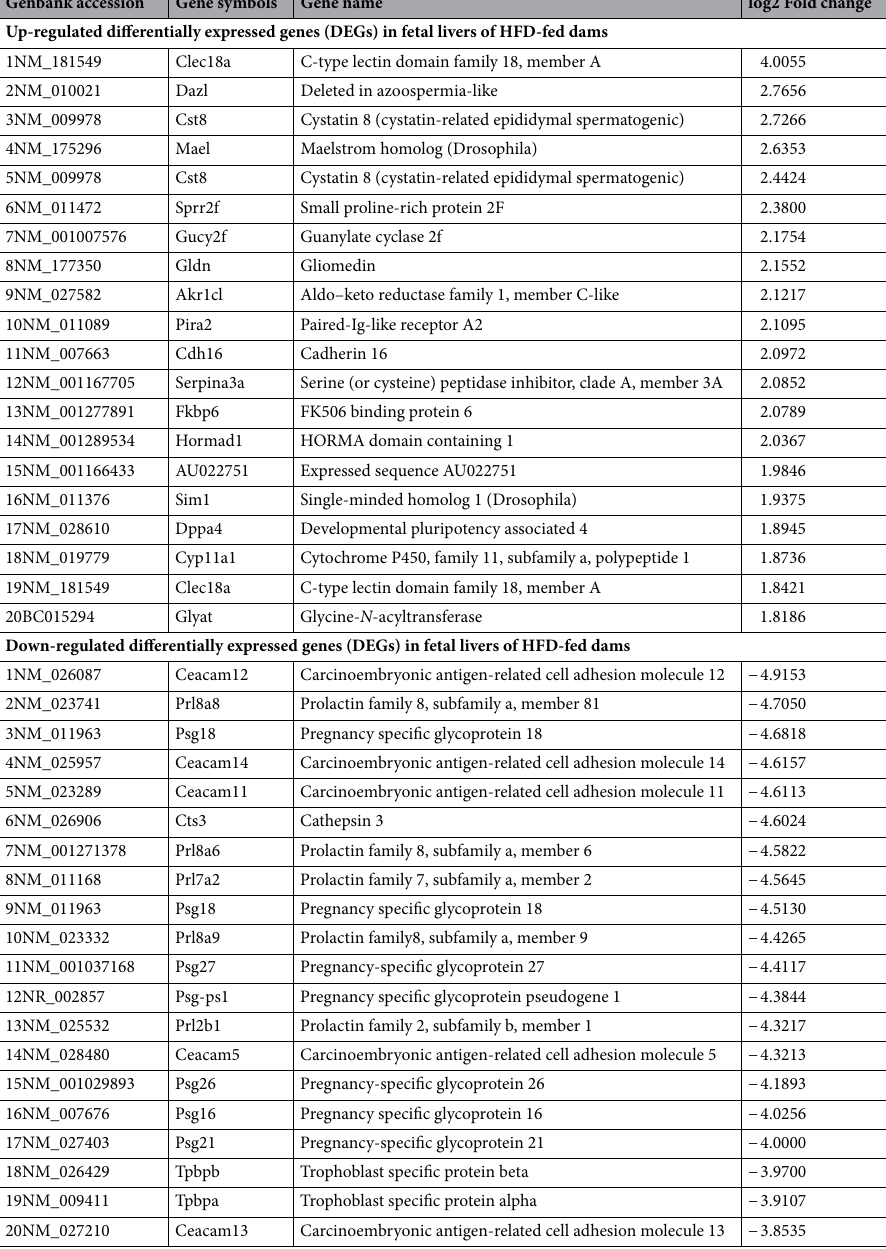
Table 1. Differentially expressed genes in fetal livers of offspring of HFD-fed dams vs . CD-fed